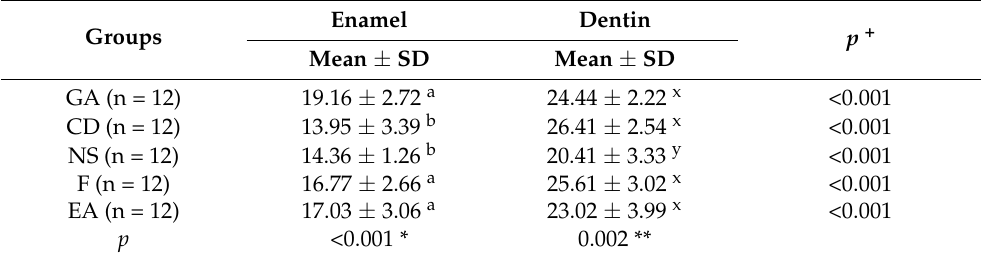
Table 4. Mean ( ± SD) bond strength (MPa) of the groups to enamel end dentin ( n = 12).